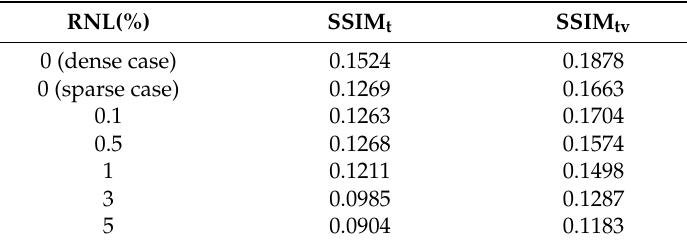
Table 2. SSIM of UTT grayscale images compared with X-CT grayscale